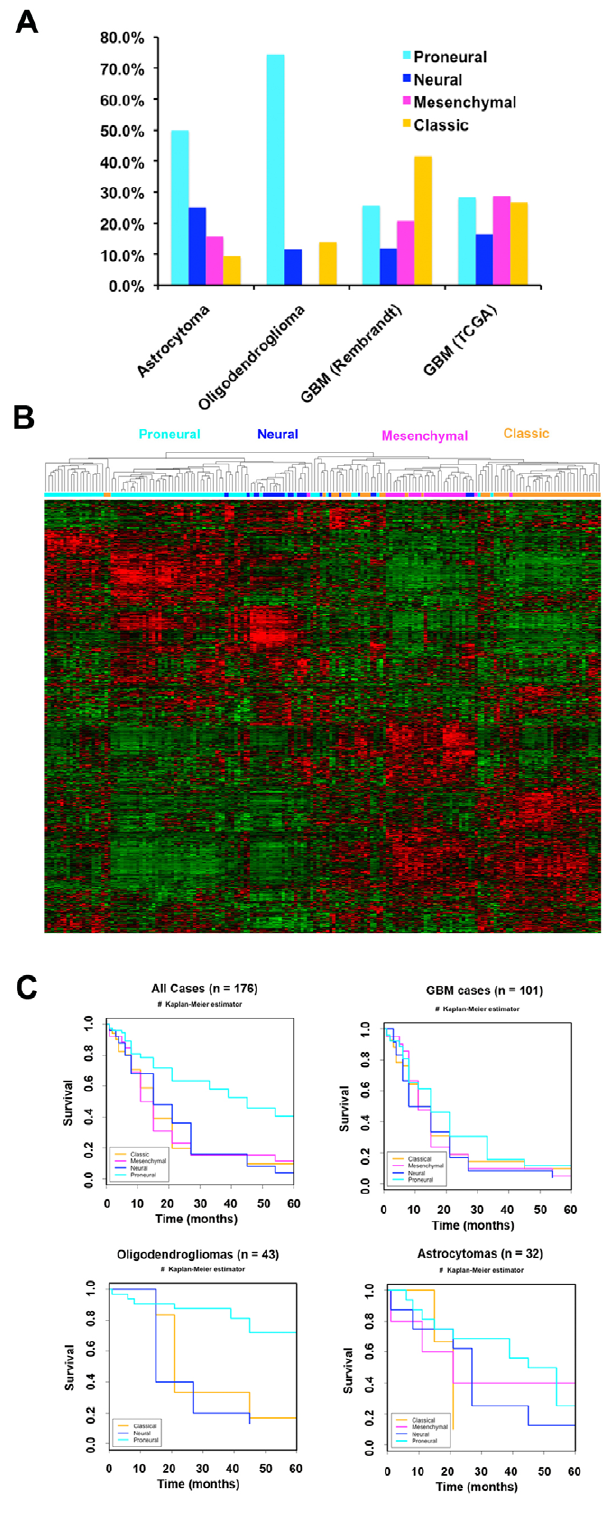
Figure 1. The proneural subtype is enriched in oligodendrogli- omas and has longer survival. ( A ) Unsupervised hierarchical clustering of 176 Rembrandt samples using TCGA classification genes identifies the four major subtypes: Proneural (cyan), Neural (blue), Mesenchymal (magenta), and Classic (orange). ( B ) Kaplan-Meier survival samples shows the Proneural subtype has significantly better survival for all cases (n=176, p=1.16e-6), and oligodendrogliomas (n=43, p=1.26e- PLoS ONE |